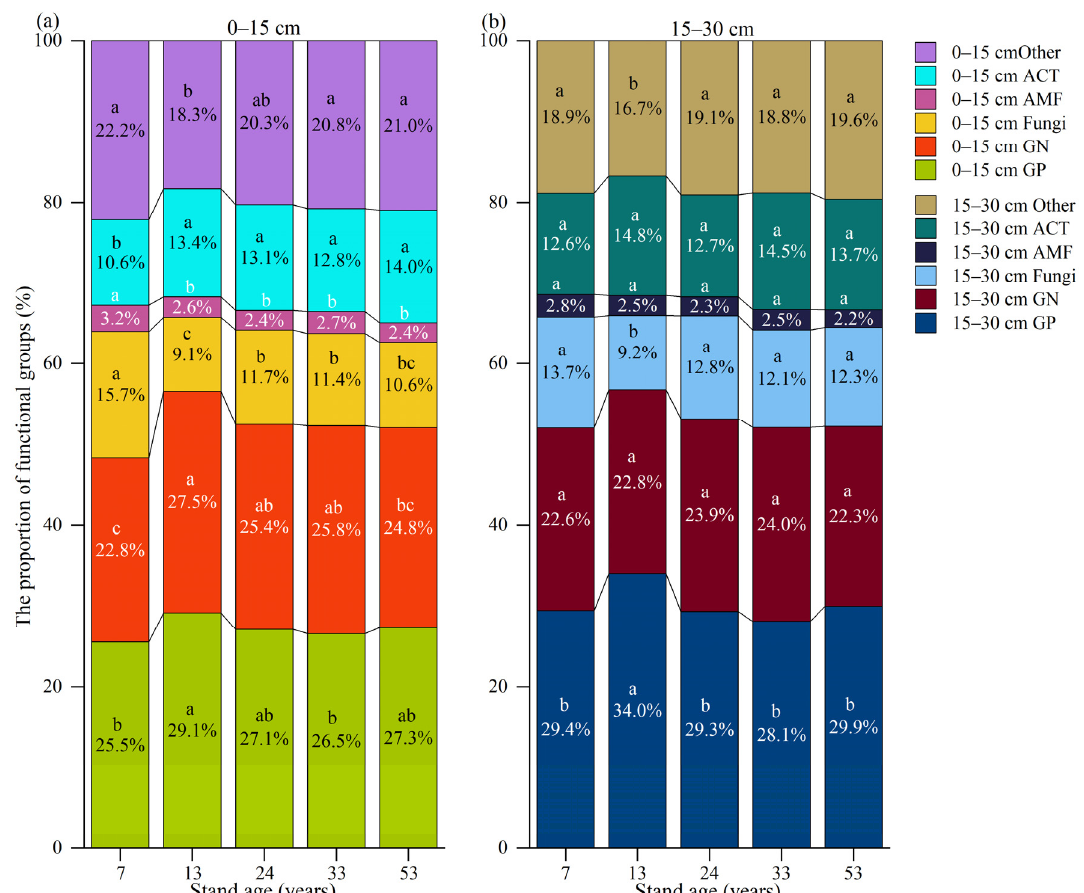
Figure 3. Changes in the proportion of functional groups from the ( a ) 0–15 cm and ( b ) 15–30 cm soil depths along the forest ages of the Chinese cedar plantations. Different lowercase letters indicate statistically significant differences between forest ages at the same soil depth. Abbreviations: sum of 16:0 and 18:0 (Other), arbuscular mycorrhizal fungi (AMF), actinomycetes (ACT), Gram ‐ negative bacteria (GN), and Gram ‐ positive bacteria (GP).